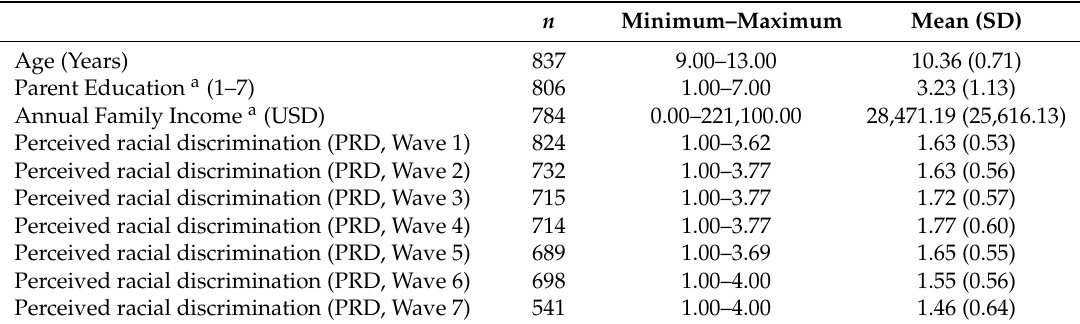
Table 1. Descriptive statistics in the pooled sample ( n = 889).